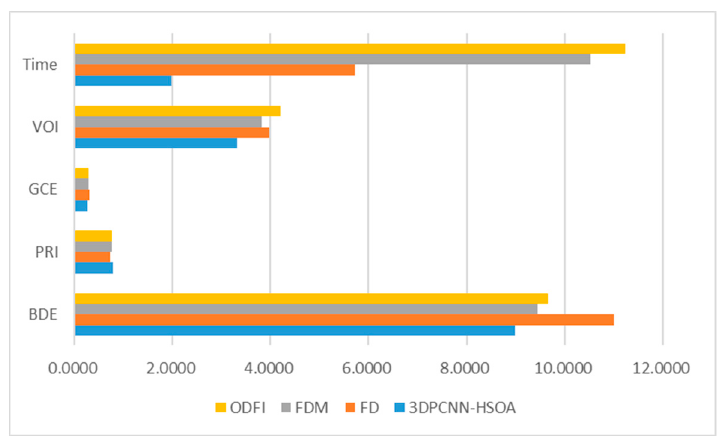
Figure 21. Bar graph of the results of each comparison algorithm.